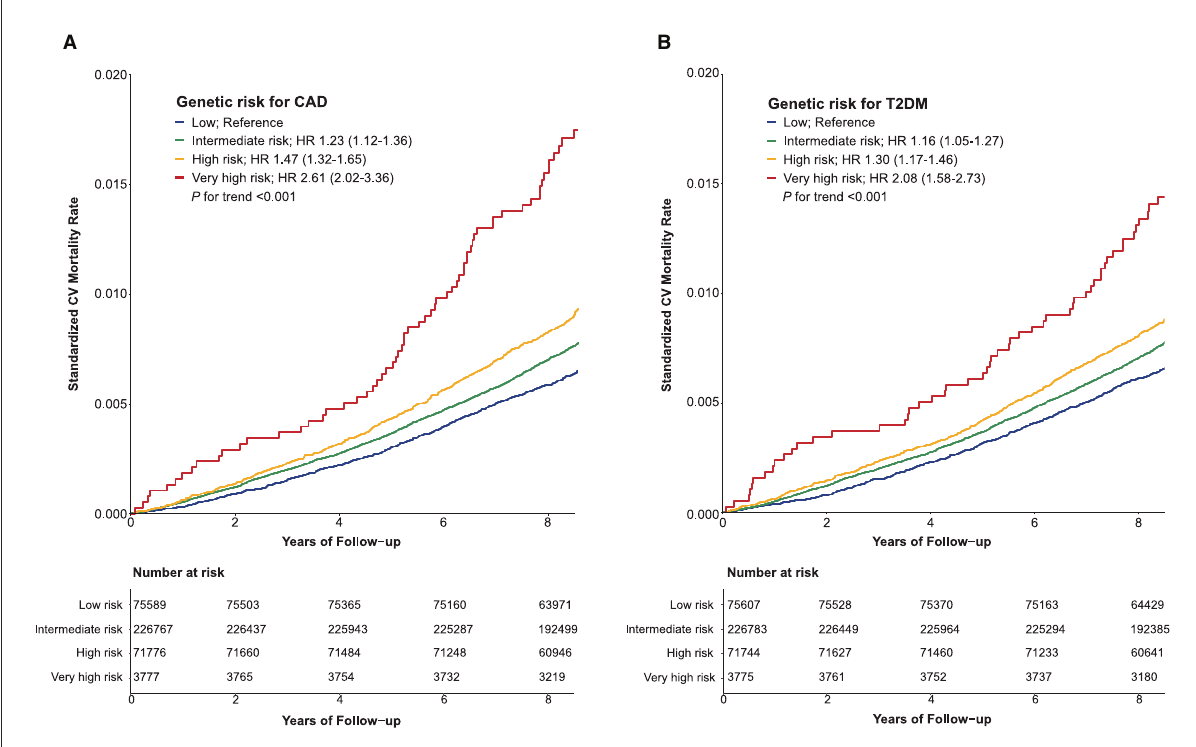
FIGURE1 Standardized cardiovascular mortality rates according to categories of polygenic risk score for coronary artery disease (A) and type 2 diabetes mellitus (B) . CAD, coronary artery disease; CV, cardiovascular; HR, hazard ratio; T2DM, type 2 diabetes